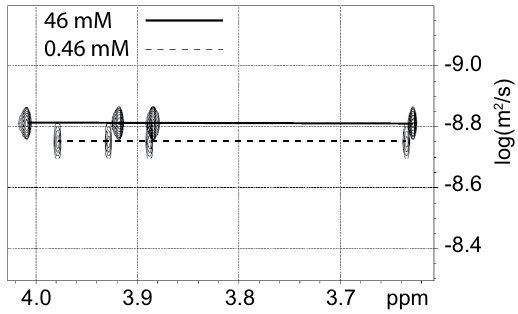
Figure 2. Overlay of the DOSY spectra for the 46 mM and 0.36 mM colchicine solutions in chloroform.